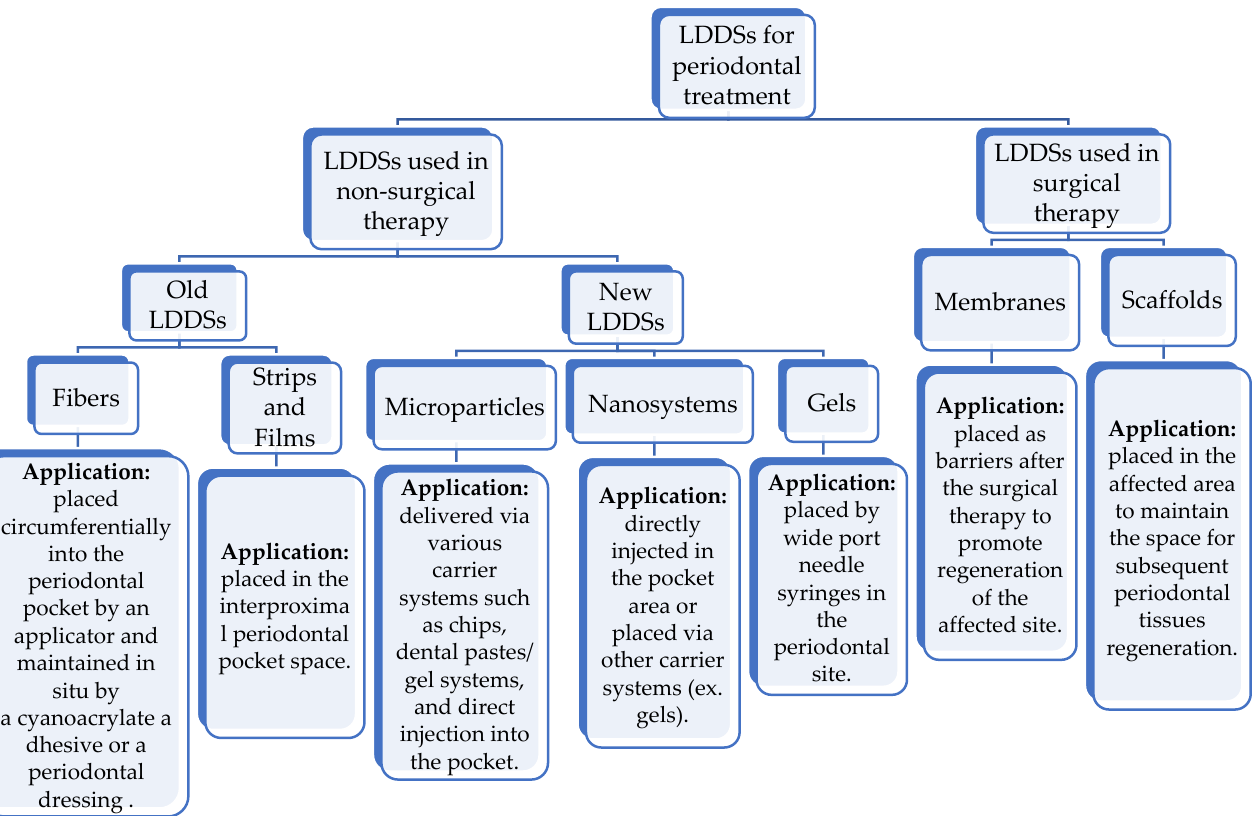
Figure 9. A flow chart of the classification of LDDSs and their modalities of application [32,122].